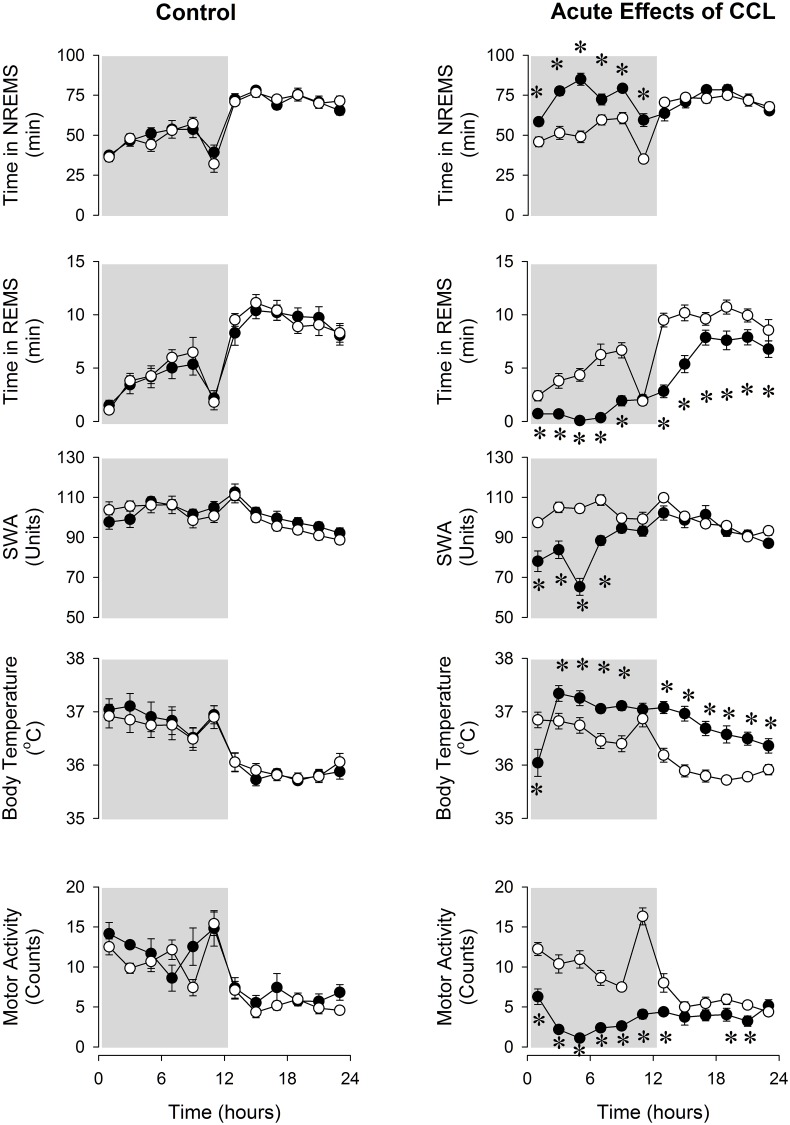
Non-rapid-eye-movement sleep (NREMS), rapid-eye-movement sleep (REMS), electroencephalogram slow-wave activity (SWA), body temperature and motor activity in control and clodronate-containing liposome (CCL)-treated mice.Open symbols: baseline day (saline injection for both groups), solid symbols: experimental day (CCL injections for the CCL-treated group and saline injection for the control group). Data are binned in 2-h time blocks. Time “0”: time of the injections at ZT12. Dark shaded areas: dark period. Error bars: standard error. Asterisks denote significant differences between baseline and treatment days (post hoc Student-Newman-Keuls test).